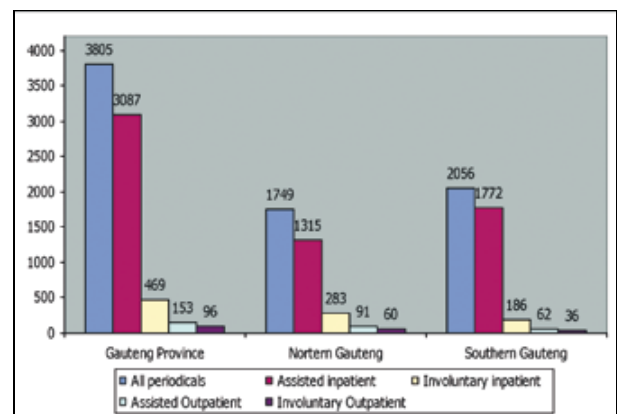
Fig. 2. Frequency distribution of periodical reports received by the